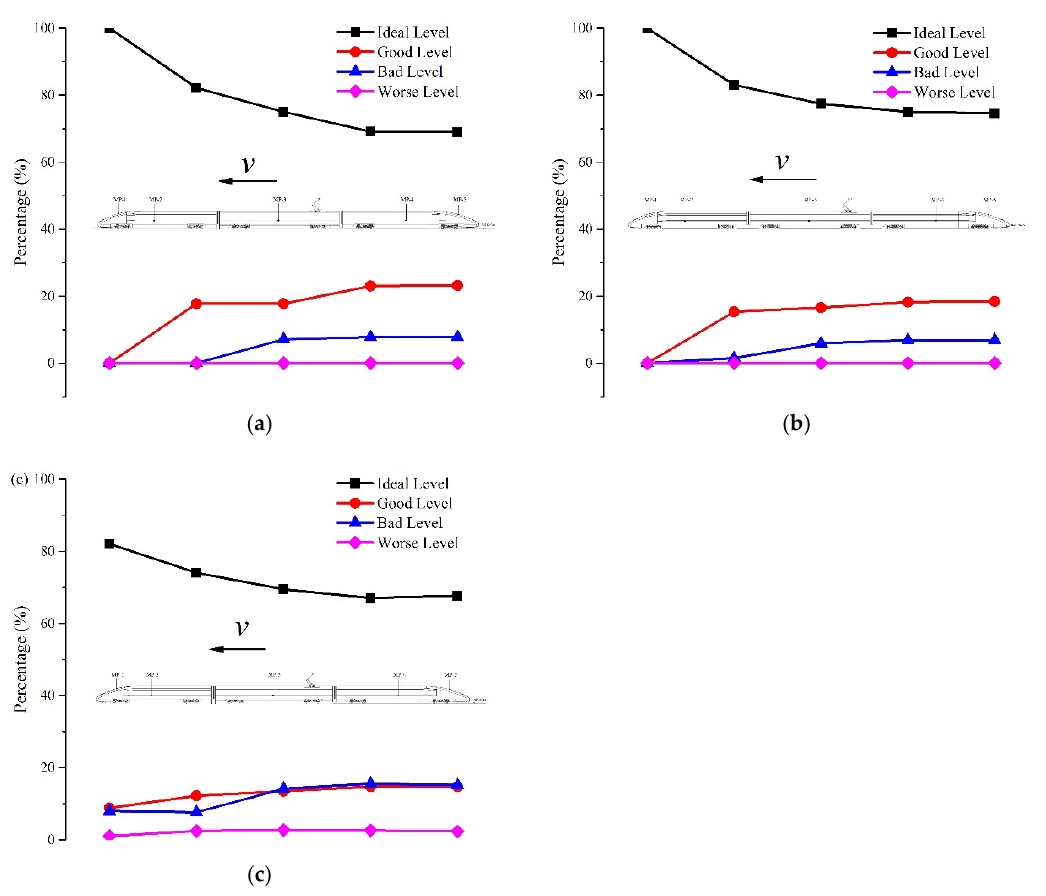
Figure 11. The relationship between car number and aural discomfort. ( a ) I1; ( b ) I2; ( c )